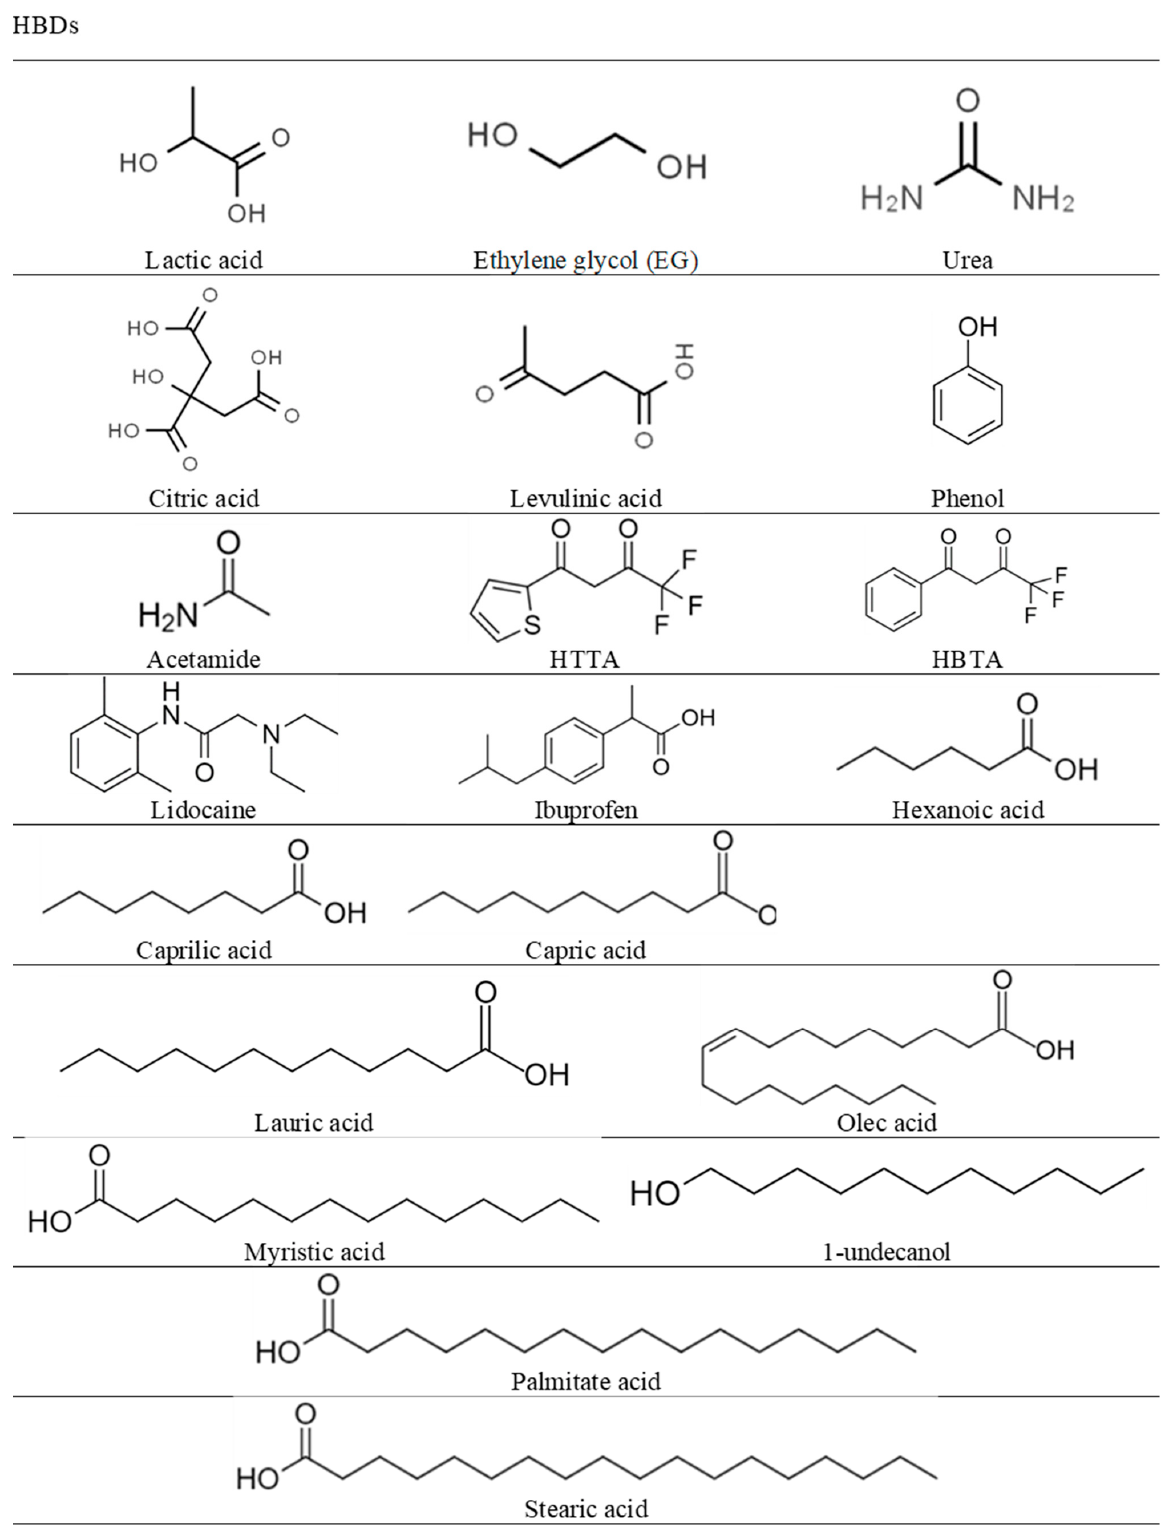
Figure 1. Structure of the hydrogen bond acceptors (HBAs) and hydrogen bond donors (HBDs) used in the synthesis of DESs for metal leaching and liquid–liquid extraction.